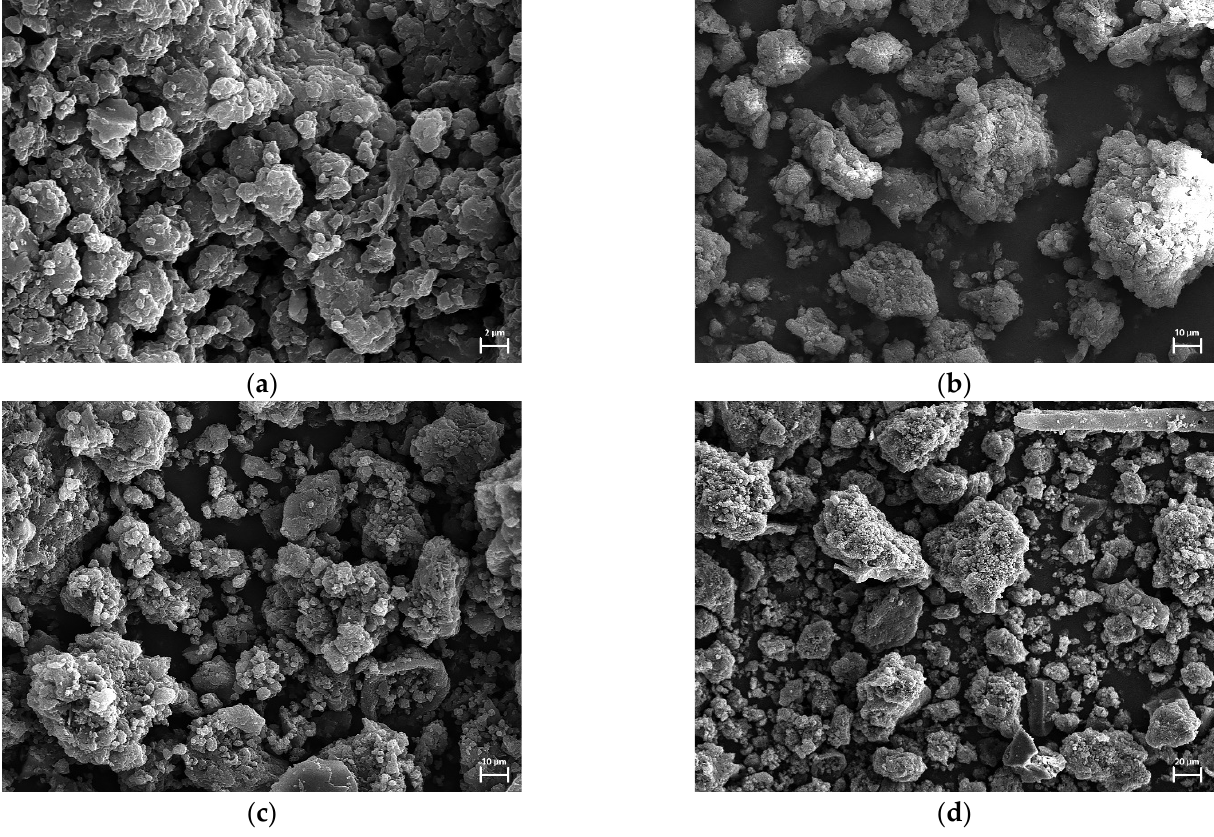
Figure 3. SEM micrographs of FA7 ( a ), CA7 ( b ), FA8 ( c ) and CA8 ( d ) prepared.